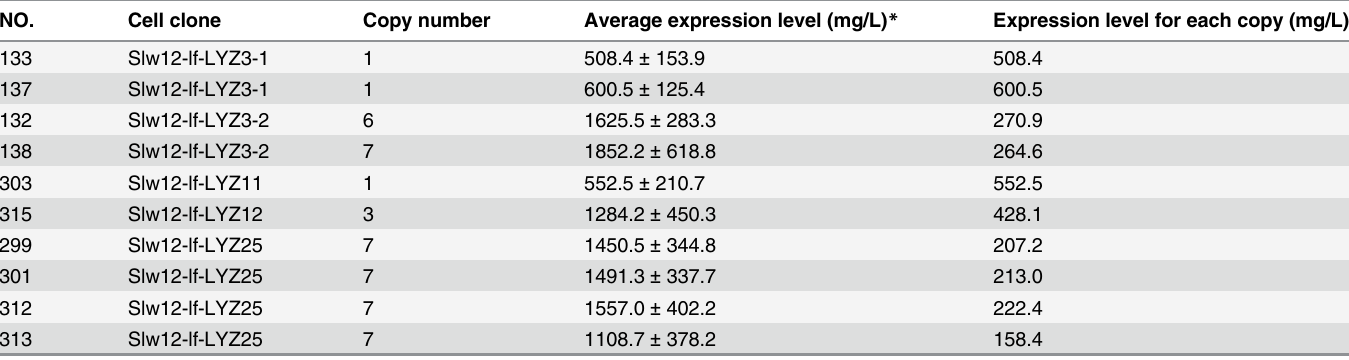
RT-PCR was conducted to assess rhLZ expression in transgenic-cloned pigs. Briefly, we isolat- ed total RNA from different tissues, including lactating mammary gland, liver, heart, spleen, kidney, stomach, lung, intestine, and muscle of transgenic sows. As a negative control, the total RNA from the mammary gland tissue of a WT sow was also isolated. To make sure extraction Table 2. Expression level of rhLZ in the milk of transgenic pigs.